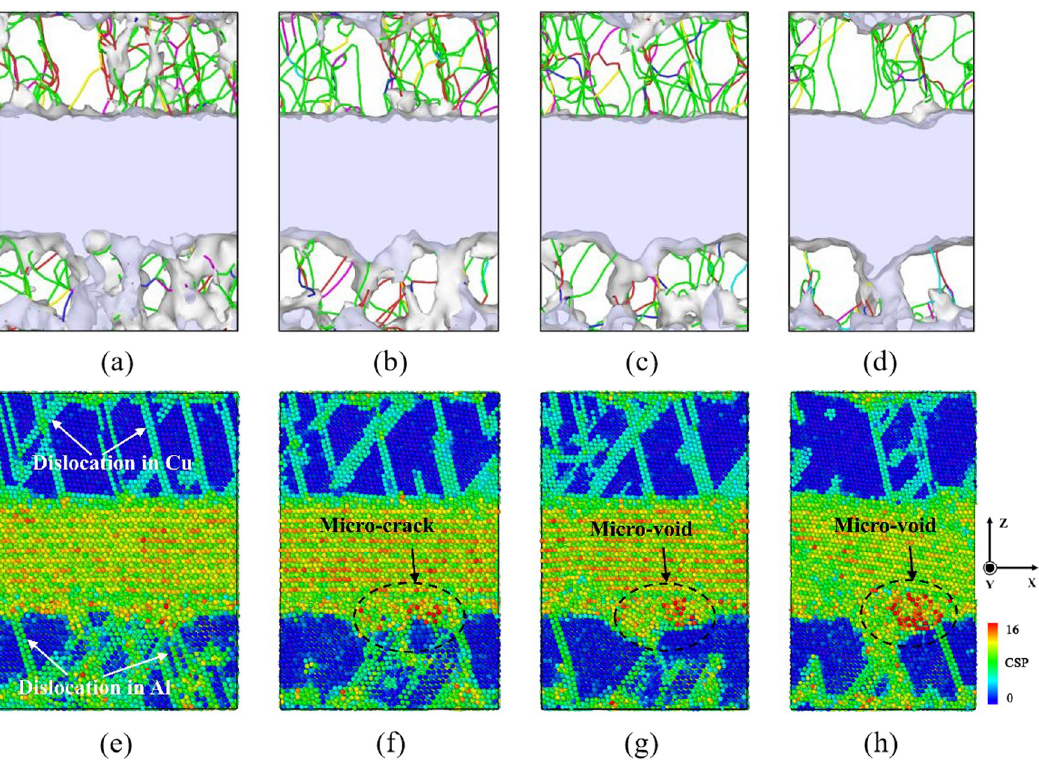
Figure 4: The Cu ( 111 ) /Al 2 Cu ( 1¯ 10 ) /Al ( 111 ) composite corresponding to the phase II mark in the tensile stress – strain curve: ( a – d ) DXA; ( e – h ) Centrosymmetric Parameter method ( CSP ) . ( a ) ε = 0.123 ( point F ) , ( b ) ε = 0.199 ( point G ) , ( c ) ε = 0.029 ( point H ) , ( d ) ε = 0.3 ( point M ) ,